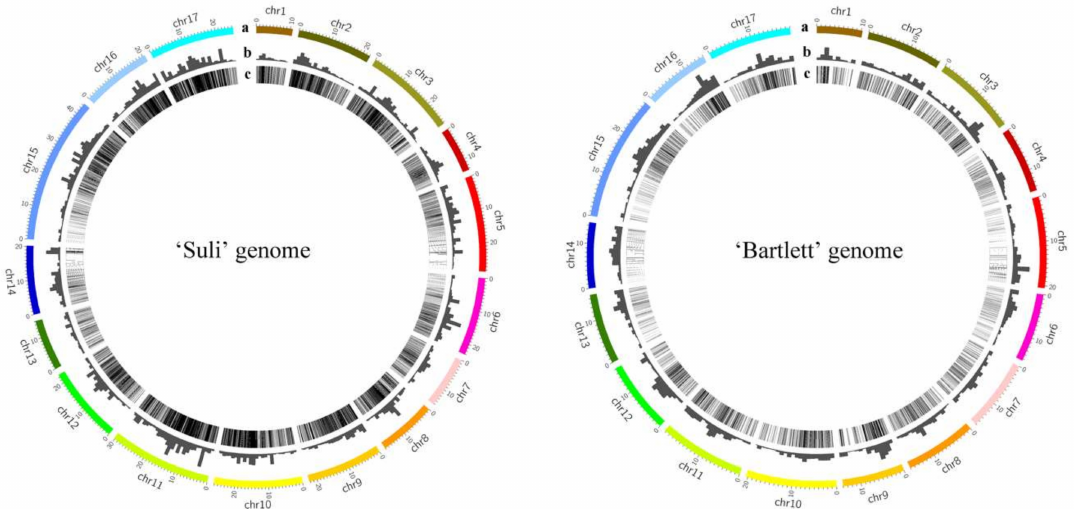
Figure 5. Distribution of the 14 LTR-RT subfamilies in the ‘Suli’ and ‘Bartlett’ genomes. ( a ) Chromosome. ( b ) Copy numbers of 14 LTR-RT subfamilies per Mb. ( c ) Distribution of 14 LTR-RT